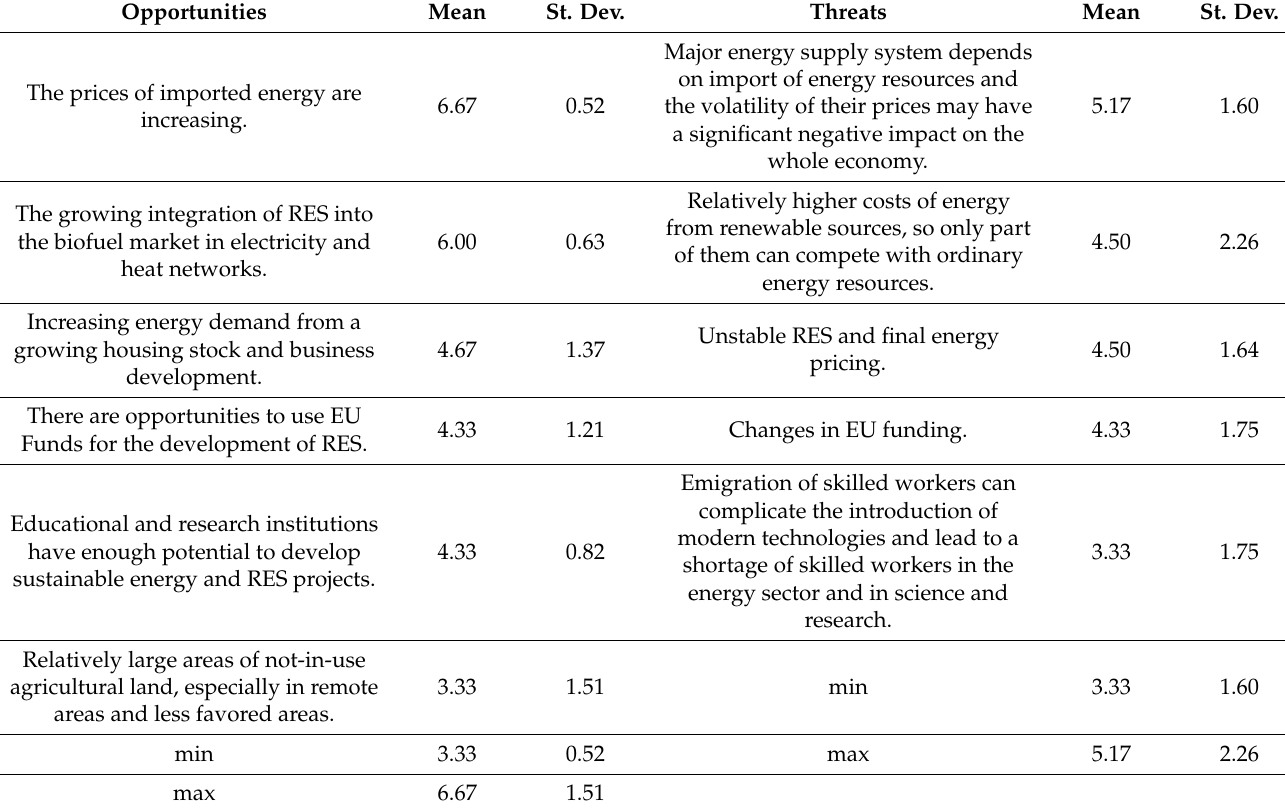
Table 5. Importance of opportunities and threats of RES development in Lithuania, mean and standard